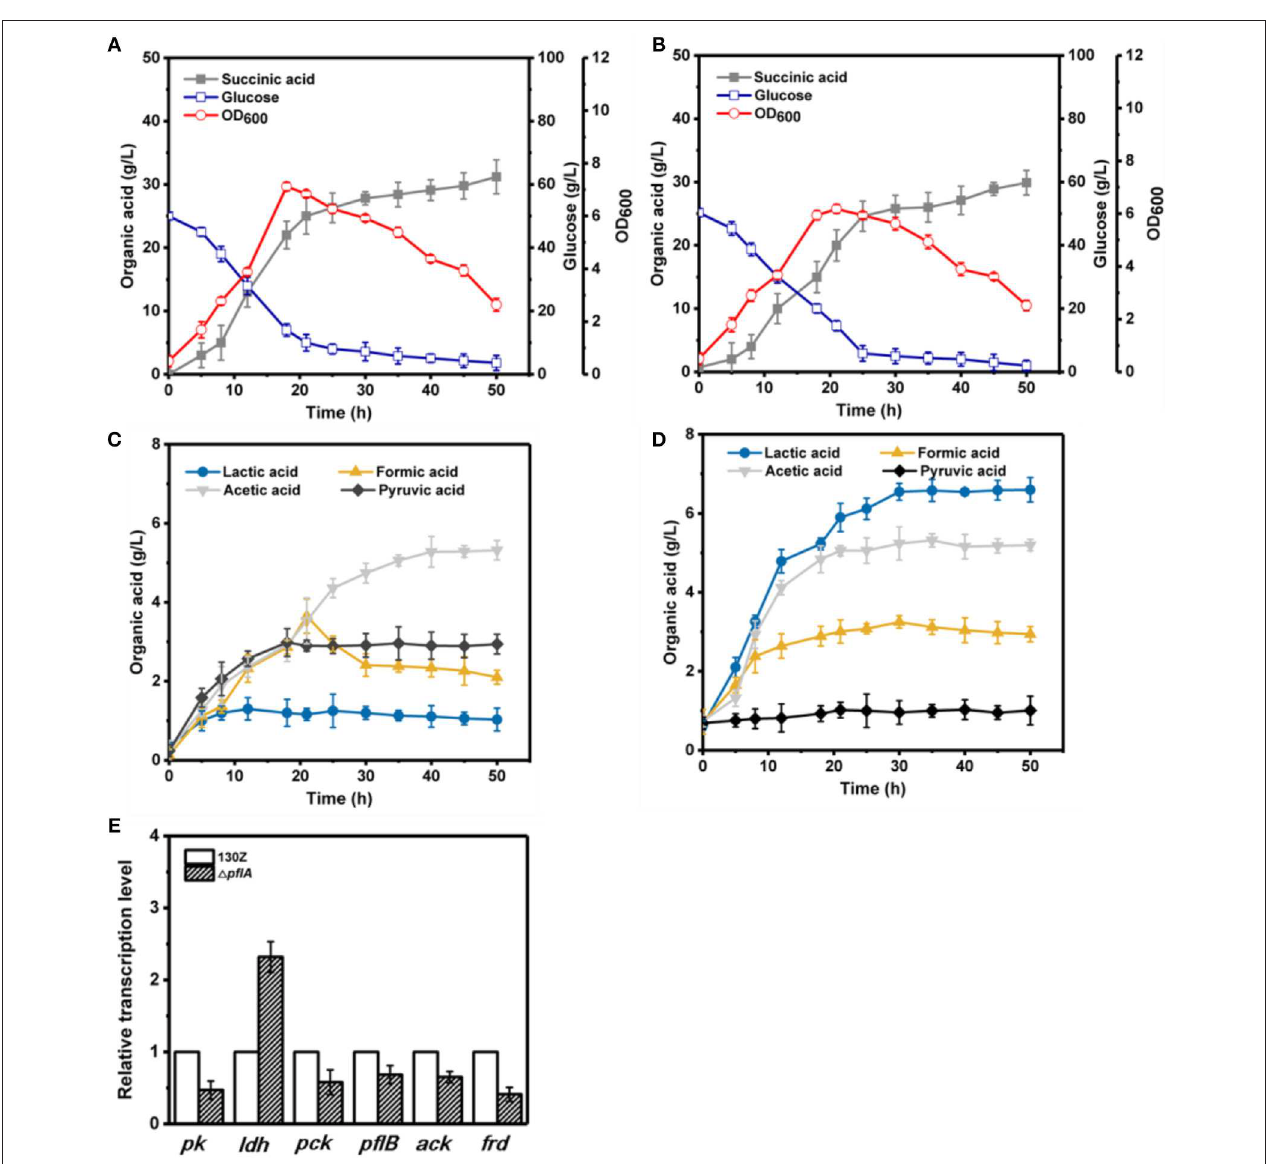
FIGURE 3 | Evaluation of different fermentation and metabolic parameters in wild-type A. succinogenes 130Z (A,C) compared to those of the 1 pflA strain (B,D) under anaerobic conditions. The bar graph (E) represents the expression levels of genes related to organic acid biosynthesis